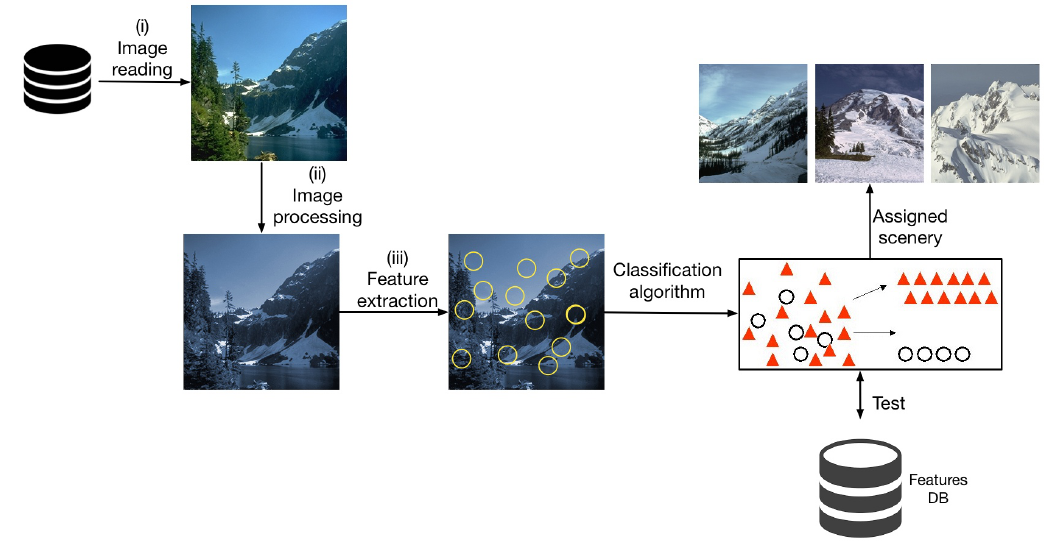
Figure 2. Classical methodology of image